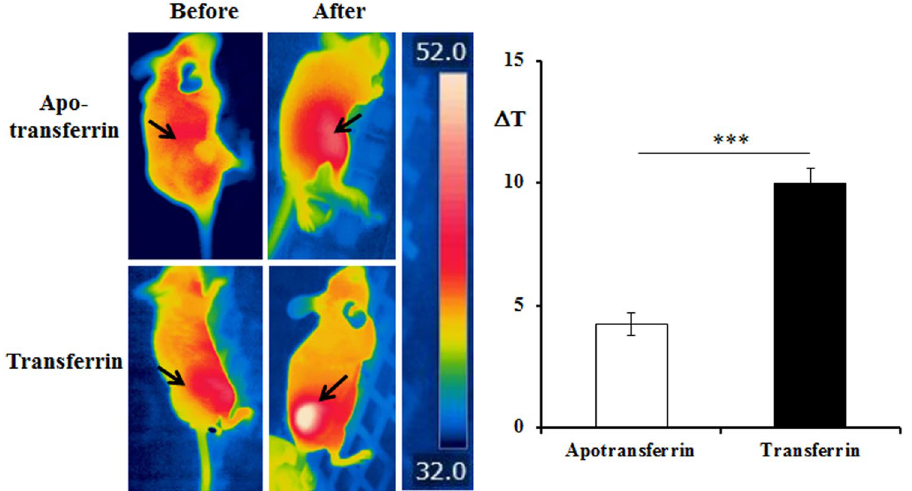
Figure 2. Ferric ion-containing transferrin boosted temperature elevation in tumor-bearing mice in the 13.56 MHz radiofrequency hyperthermia in vivo . Tumor-bearing mice were given i . v . injection with either apotransferrin or transferrin and the temperature of tumor tissues was recorded before and after 13.56 MHz radiofrequency hyperthermia for temperature change ( Δ T) calculation. The temperature elevation in tumor tissue was dramatically boosted by local hyperthermia using a 13.56 MHz radiofrequency hyperthermia with transferrin but not with apotransferrin. The values represent the mean ± standard deviation ( n = 6). A paired Student’s t-test was used for the statistical analysis; *** p <